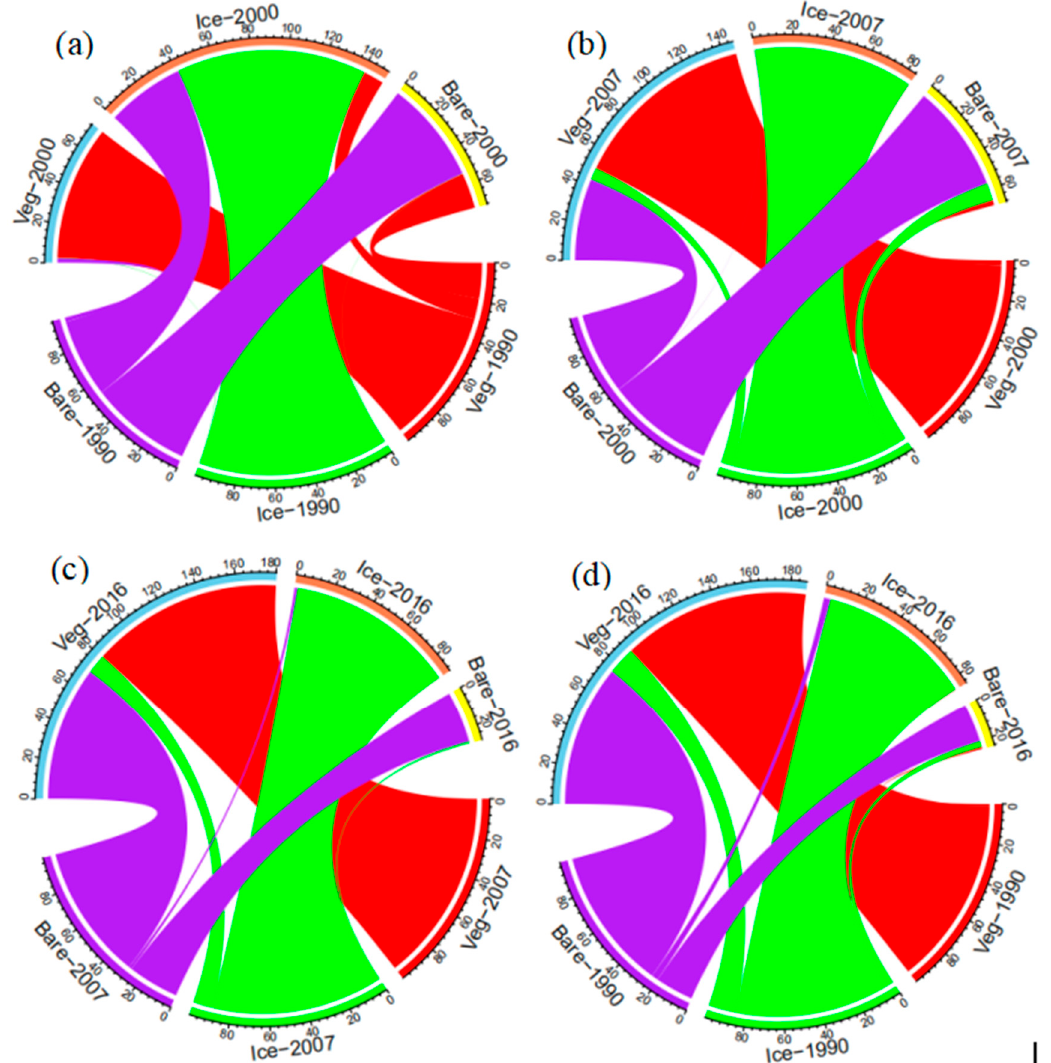
Figure 6. Landscape type transition matrix in the study area. ( a–d ) show the changes from 1990 to 2000, 2000 to 2007, 2007 to 2016, and 1990 to 2016. A-B refers to land cover type A in year B. e.g., Veg-1990 indicates that the type of land cover in 1990 was vegetation.